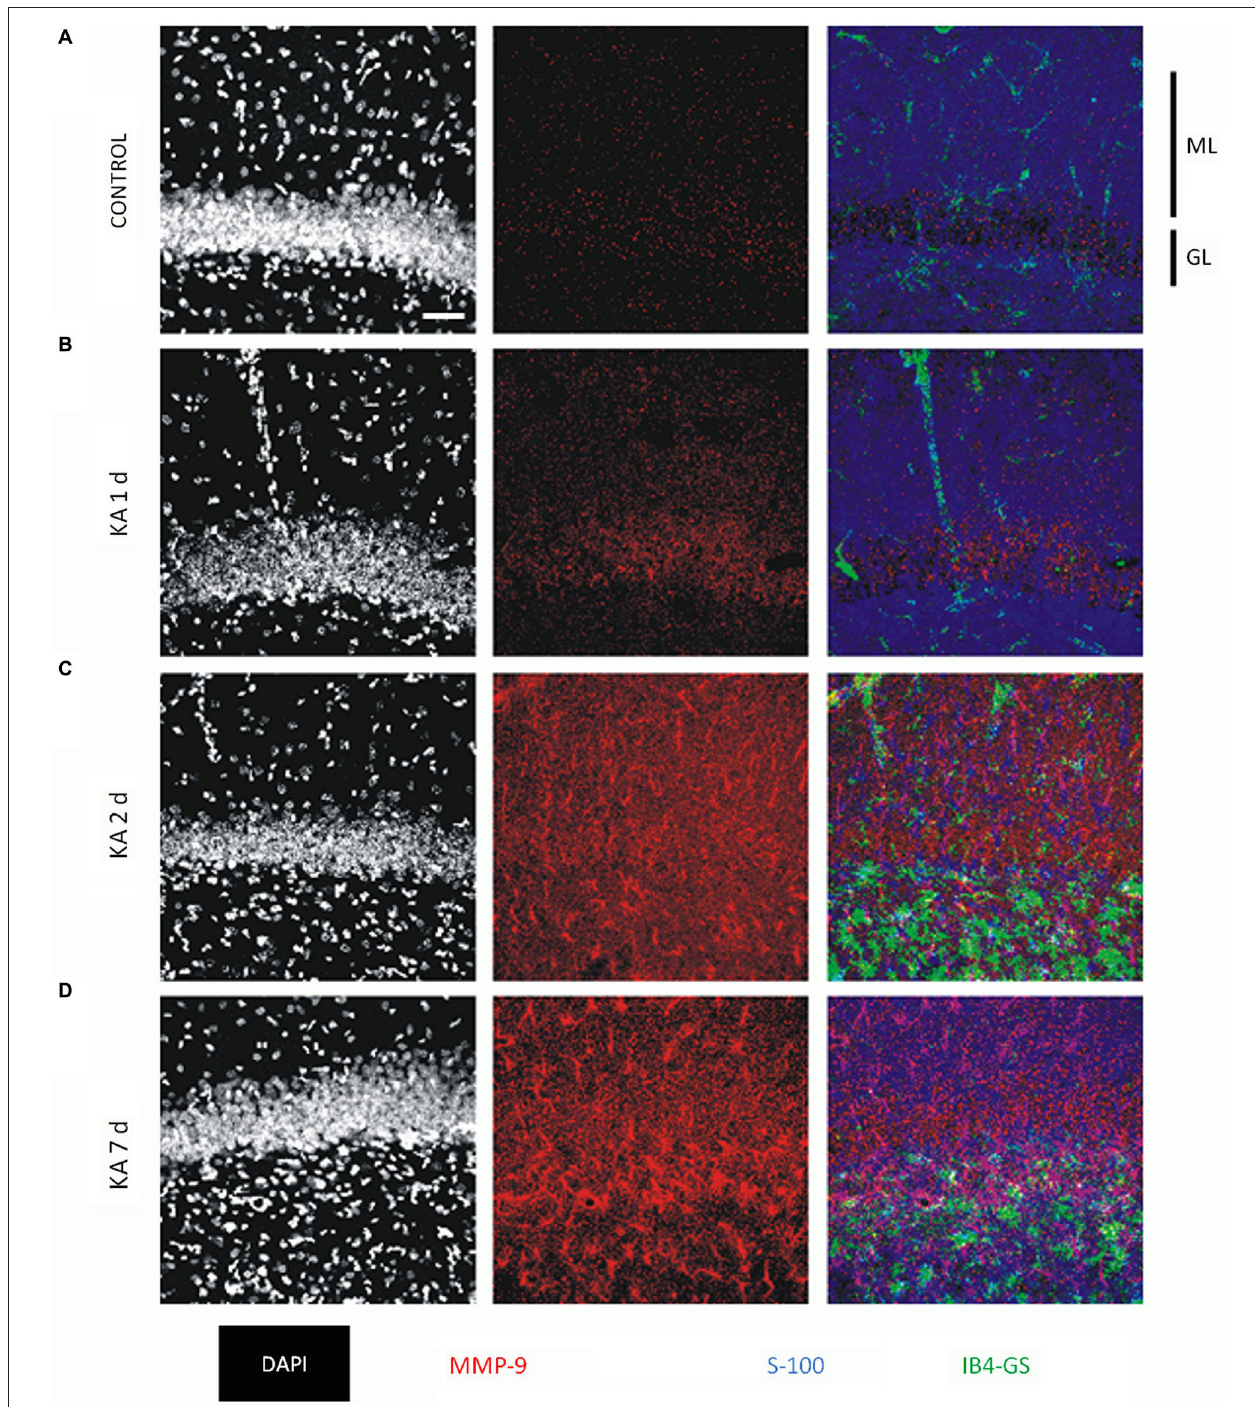
reservoir is enriched with astrocytic pool. Confocal images from brain tissue labeled with nuclear marker (DAPI—white), MMP-9 antibody (red), astrocyte marker anitbody (S-100, blue), microglia marker antibody (IB4-GS, green). GL—granular layer, ML—molecular layer. Scale bar 50 µ m. The experiment was performed by dr Grzegorz Wilczynski. For further reference, see Wilczynski et al.